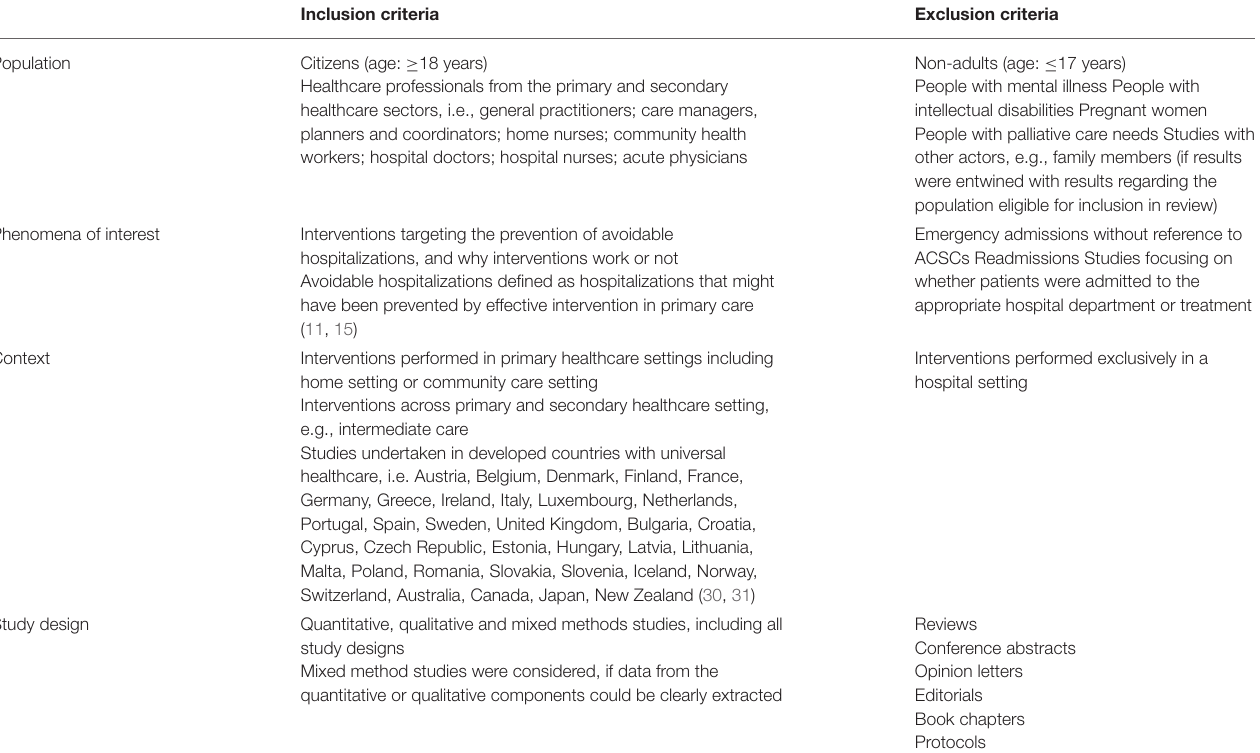
TABLE 1 | Inclusion and exclusion